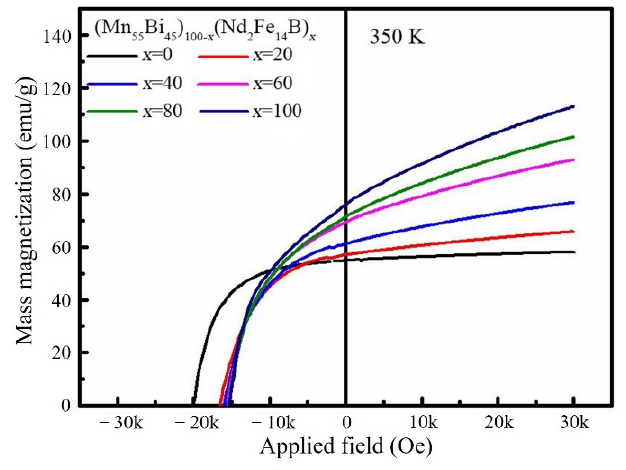
Figure 7. The demagnetization curves of the bulk (Mn 55 Bi 45 ) 100- x /(Nd 2 Fe 14 B) x ( x = 0, 20, 40, 60, 80, and 100) hybrid magnetic alloys at 350 K.